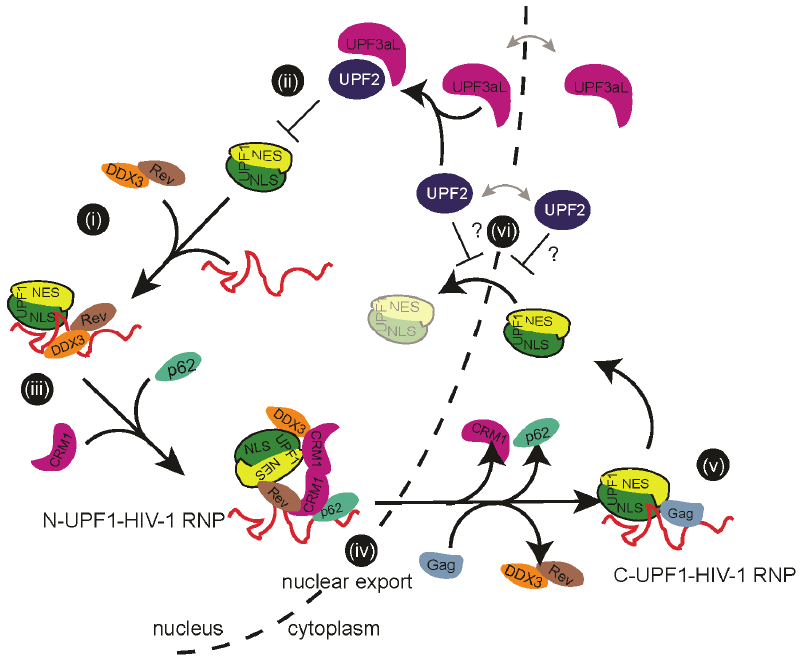
Figure 8. Proposed model for UPF1-mediated vRNA nucleocytoplasmic export. During the HIV-1 expression phase, the shuttling ability of UPF1 is important for vRNA